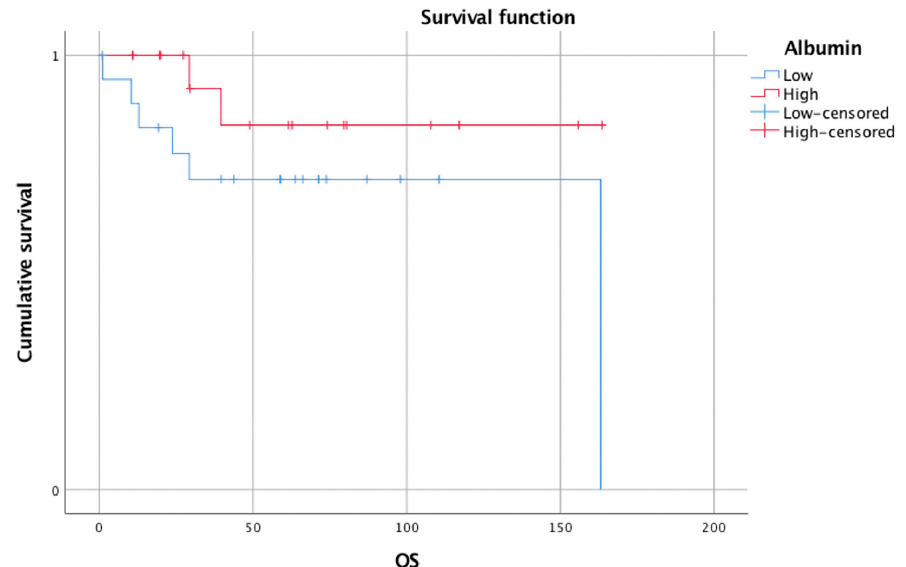
Figure 1. Kaplan–Meier survival curve for OS for patients stratified according to median prethera- peutic serum albumin value. The OS for the low albumin group ( n = 19) was shorter than for the high albumin group ( n = 18). A log-rank test revealed no significant difference ( p = 0.155). OS: overall survival.